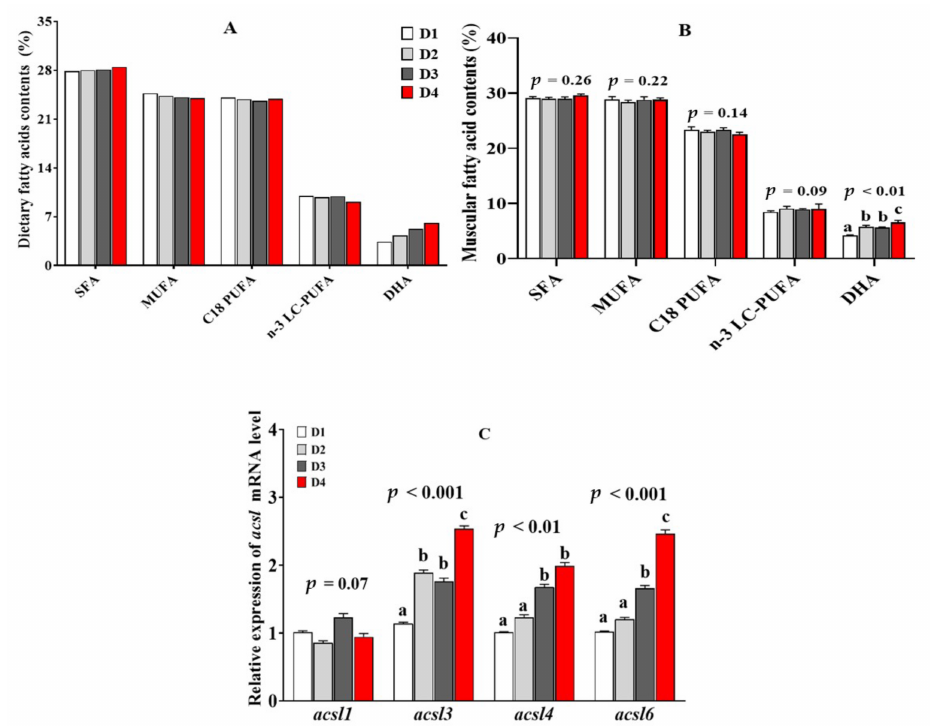
Figure 5. Muscular fatty acid contents ( B ), and acsl family mRNA relative level ( C ) of juvenile Trachinotus ovatus fed diets with different DHA levels ( A ). Values are means ± SEM from three treatments of fish ( n = 3) with three fish per cage, and bars not sharing a common letter indicated significant differences ( p < 0.05) among deletions determined by one-way ANOVA followed by Tukey’s multiple